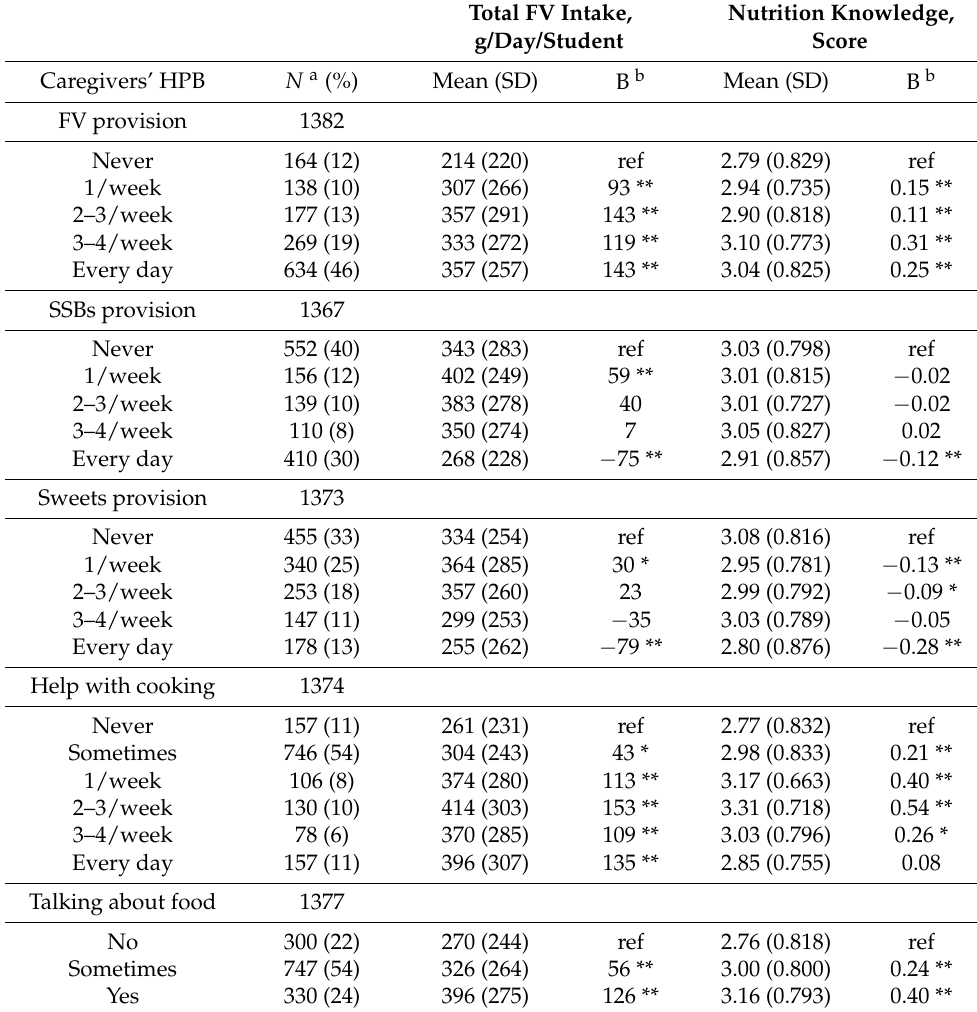
Table 2. Association between caregivers’ health promotion behaviour (HPB) and children’s FV intake and nutrition knowledge, at baseline